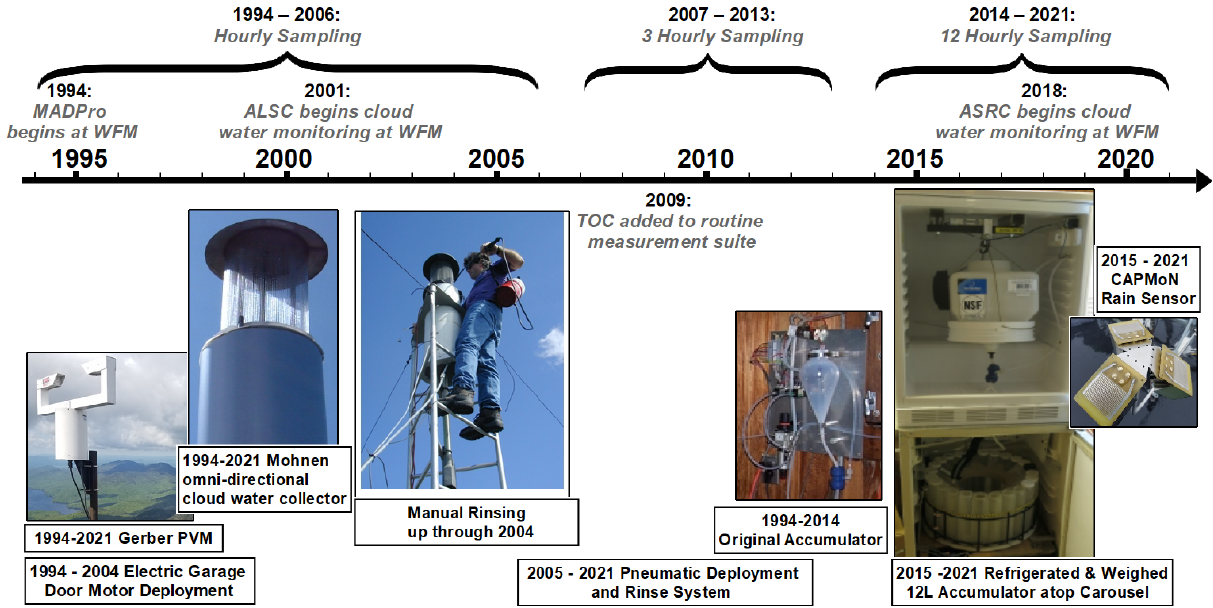
Figure 1. Timeline of major events in cloud water collection at WFM for the routine long-term dataset analyzed in this paper (1994– 2021), with sampling conducted by the mountain acid deposition program (MADPro) 1994–2000, the Adirondack Lake Survey Corporation (ALSC) 2001–2017 and the Atmospheric Sciences Research Center (ASRC) 2018–2021, and two major system overhauls in 2005 and in 2015. While ASRC conducted the cloud water sampling in recent years, the majority of the chemical analysis was conducted by the Adirondack Watershed Institute (AWI) in 2018 and 2019 and by ALSC in 2020 and 2021. The same basic protocols, cloud water collector and liquid water content sensor were used throughout this entire measurement period, but sampling frequency decreased from hourly to 3-hourly to 12-hourly, necessitating a larger accumulator vessel and an additional refrigerator to house it. Automated filtering began in 2018. Photos documenting the manual rinsing process and the original accumulator were obtained from Eric Hebert, Environmental Engineering and Measurement Services,